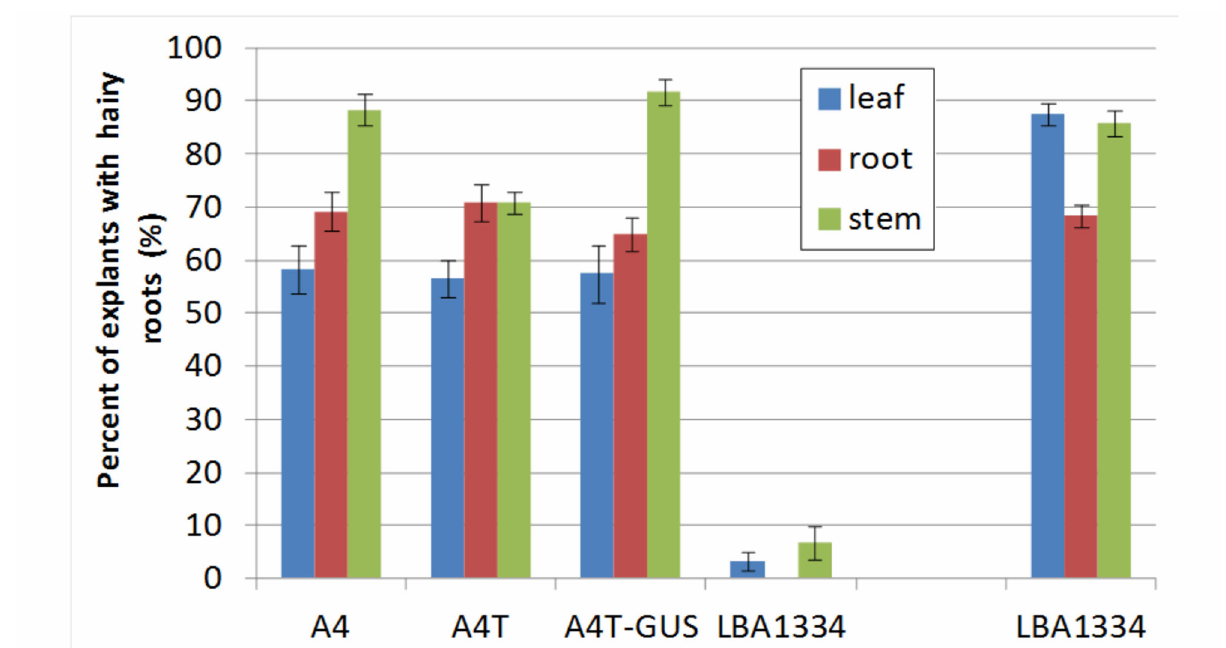
FIGURE 2 - Percentage of H. sinaicum explants exposed to a solid MS medium and developing hairy roots four weeks after transformation with four A. rhizogenes strains. Additionaly, percentage of tobacco explants with hairy roots after inoculation with the LBA1334 strain. Whiskers - standard error.